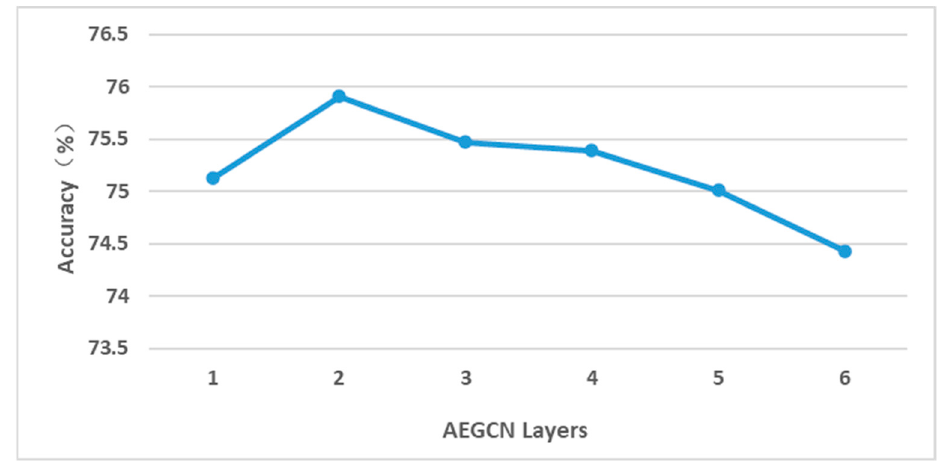
Figure 4. Impact of the AEGCN layers.